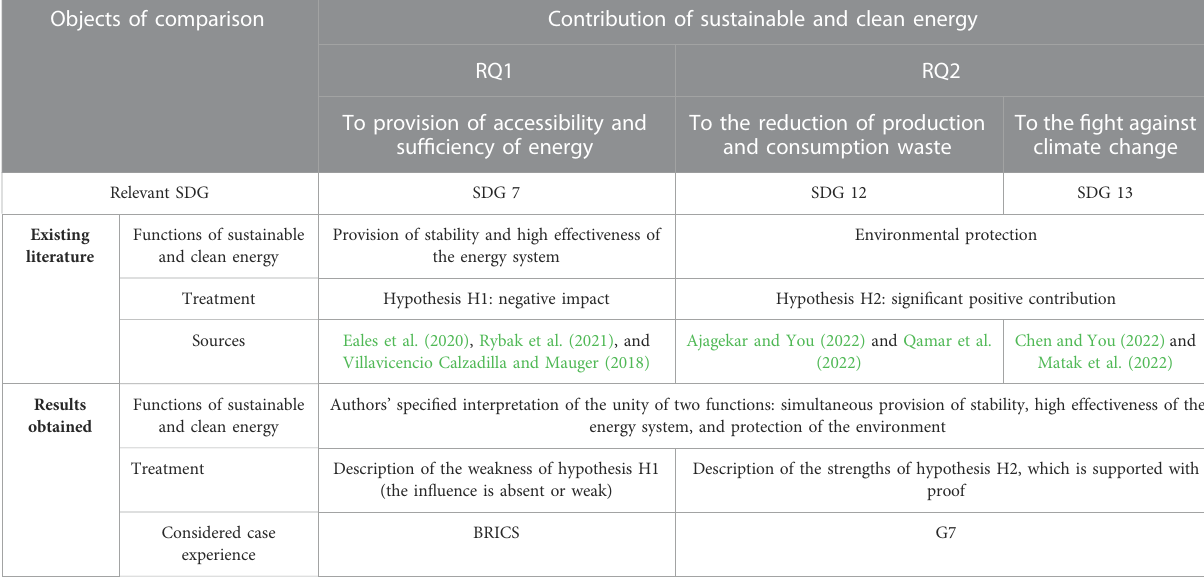
TABLE 1 Comparison of the results obtained and the literature. Objects of